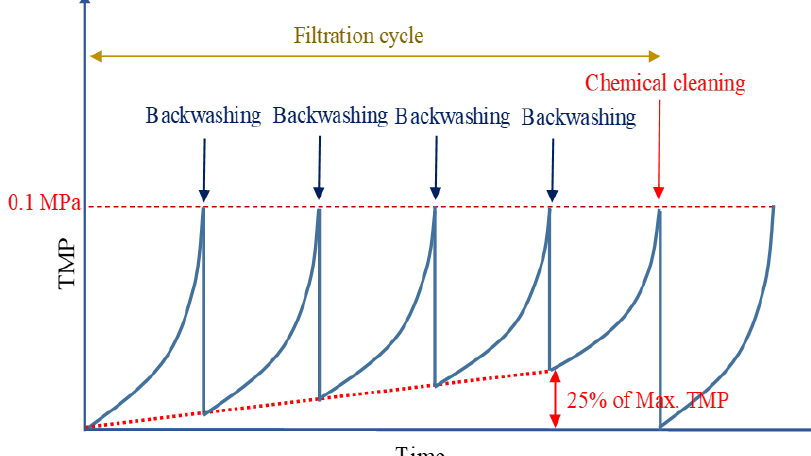
Figure A4. Transmembrane pressure graph.